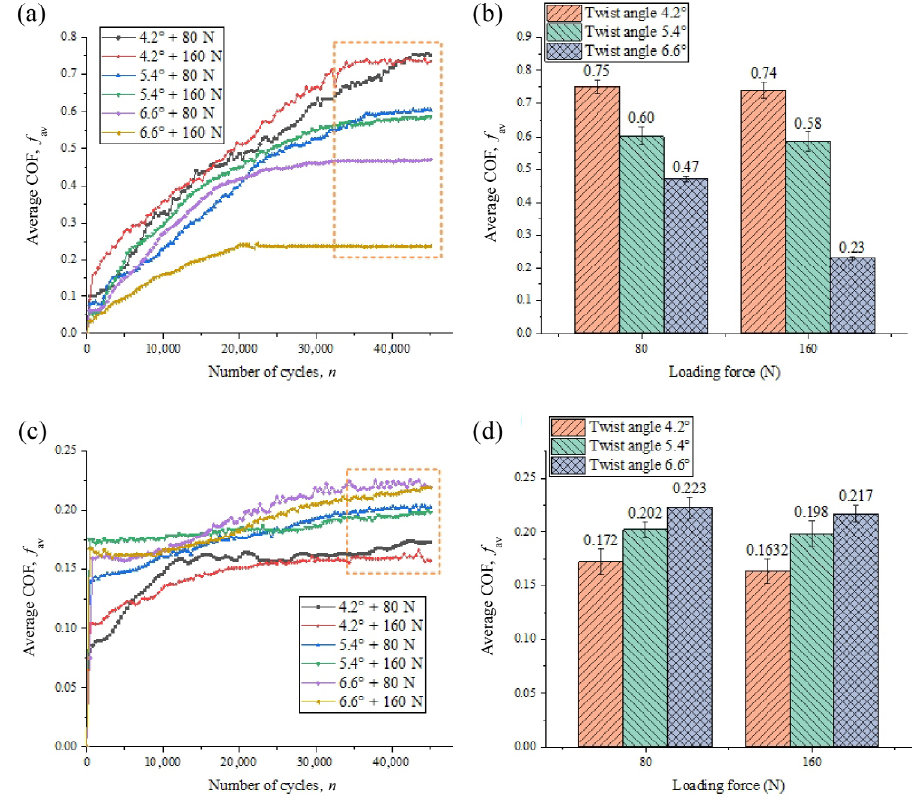
Fig. 9 COFs of different twist angles and lateral loads under dry friction and oil lubrication